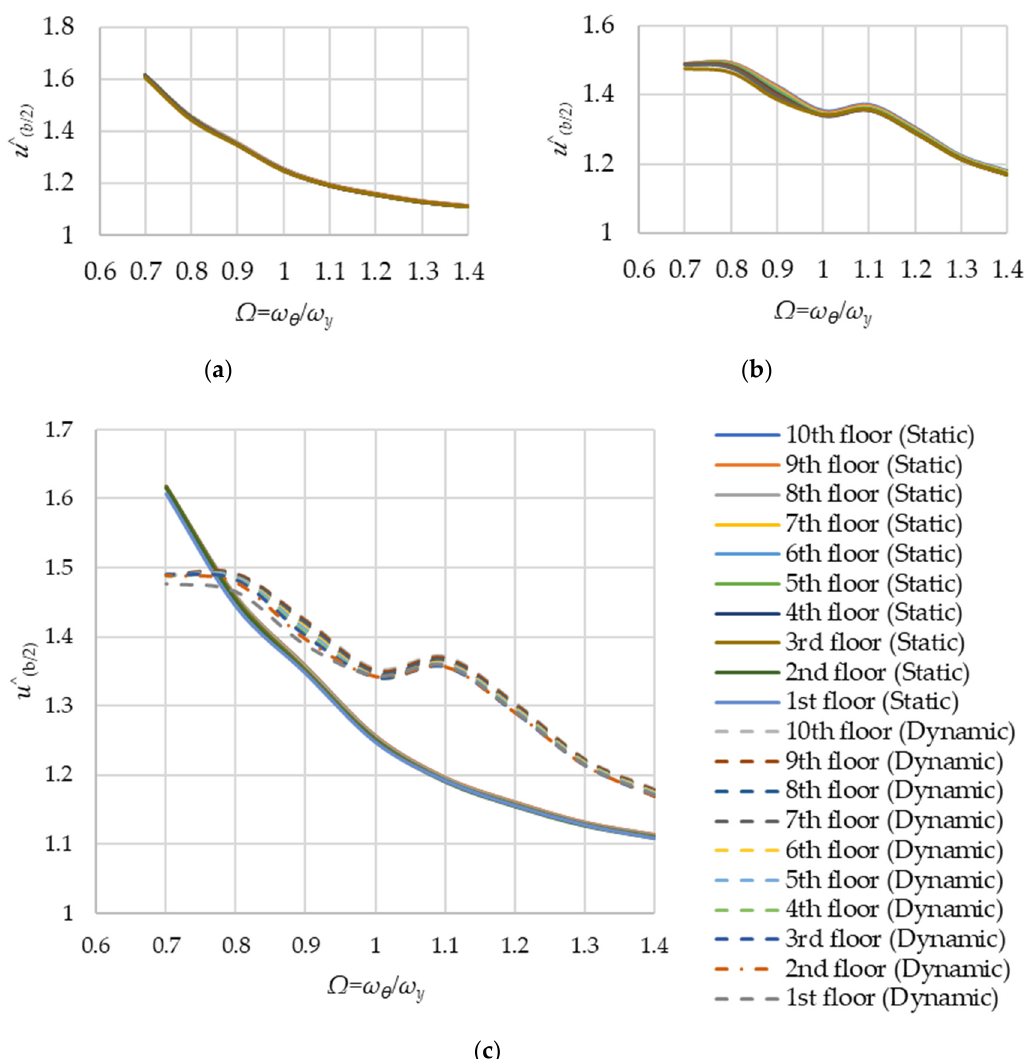
Figure 9. Normalized flexible edge displacement (with b / r = 1.4, 1 < Ty < 2 s): ( a ) Static edge displacement; ( b ) Dynamic edge displacement; ( c ) Static vs. dynamic edge displacement.